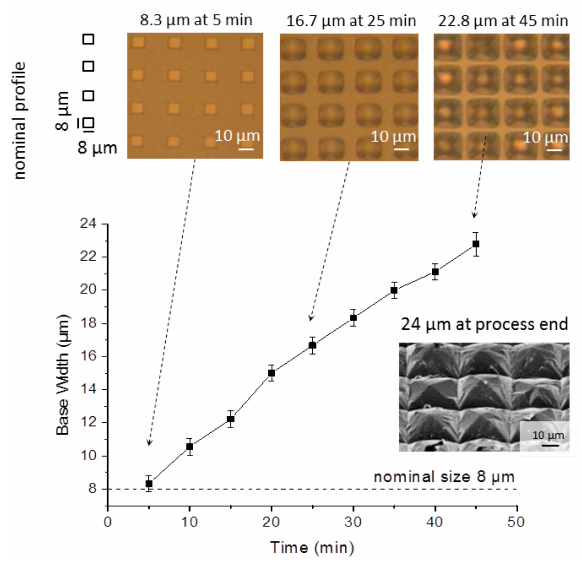
Figure 5. Evolution of base width, along the wet etch process, obtained from a 8 μm × 8 μm square mask with a spacing of 16 μm, under IPA saturated conditions, as described for sample 4 in Table 1. Top view microscope images show how the individual square patterns are enlarged and merged together.